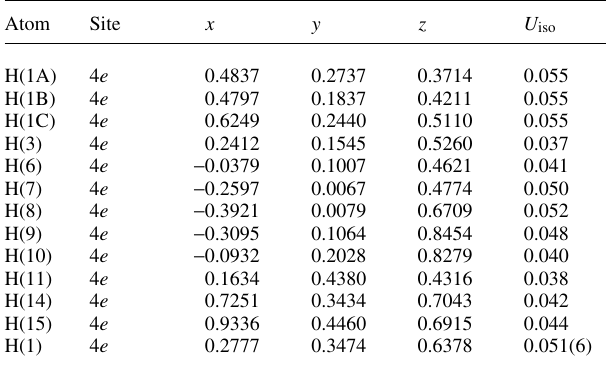
Table 2. Atomic coordinates and displacement parameters (in Å 2 )